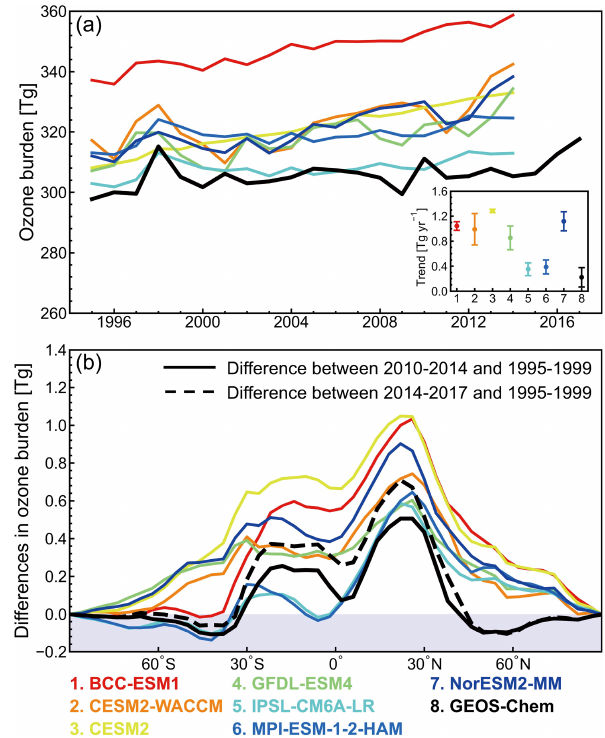
Figure 8. Evolution of 1995–2017 tropospheric ozone burden from GEOS-Chem and seven CMIP6 models (available for 1995–2014) used in this study. (a) The time series of tropospheric ozone bur- den integrated from 90 ◦ S to 90 ◦ N for the period 1995 to 2017. The black line represents the results of the GEOS-Chem simulation, and colored lines are from CMIP6 models. Dot plots show the tro- pospheric ozone burden trends for 1995–2014 in different models with the vertical bars showing the 95% confidence interval. (b) The differences in zonal integrated tropospheric ozone burden for the nine models between 2010–2014 and 1995–1999 (solid line) and for GEOS-Chem between 2014–2017 and 1995–1999 (dashed